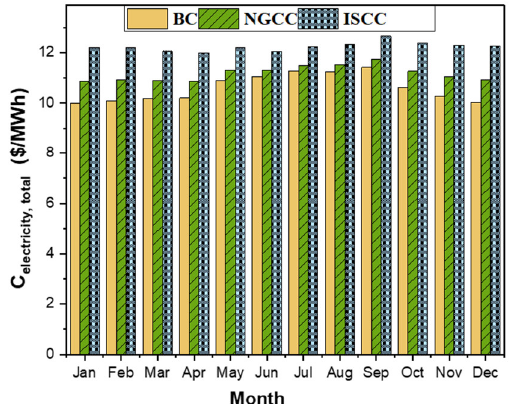
Figure 8. The overall unit cost of production for B.C., NGCC, and ISCC per month.